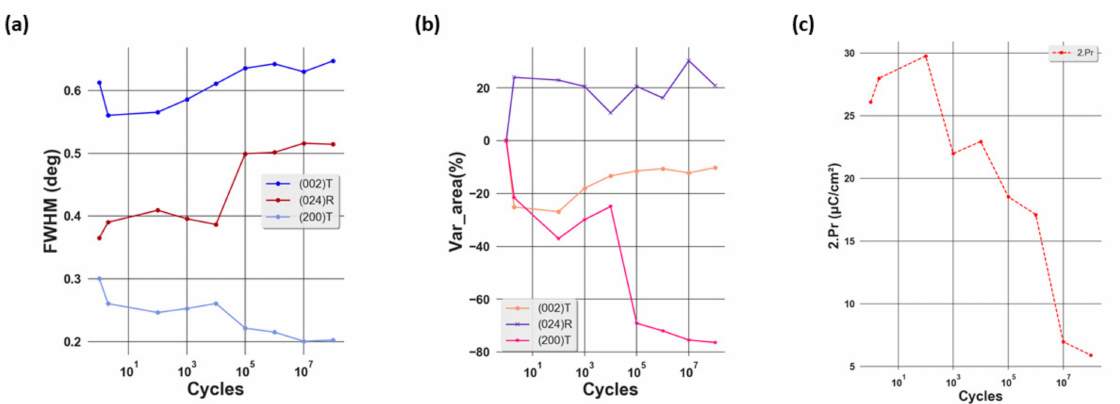
Figure 3. Evolution of ( a ) FWHM, ( b ) surface area of the XRD peak of different phases, and ( c ) the total remanent 2.P R ( 2.P R = | P R + | + | P R − |) as a function of electric